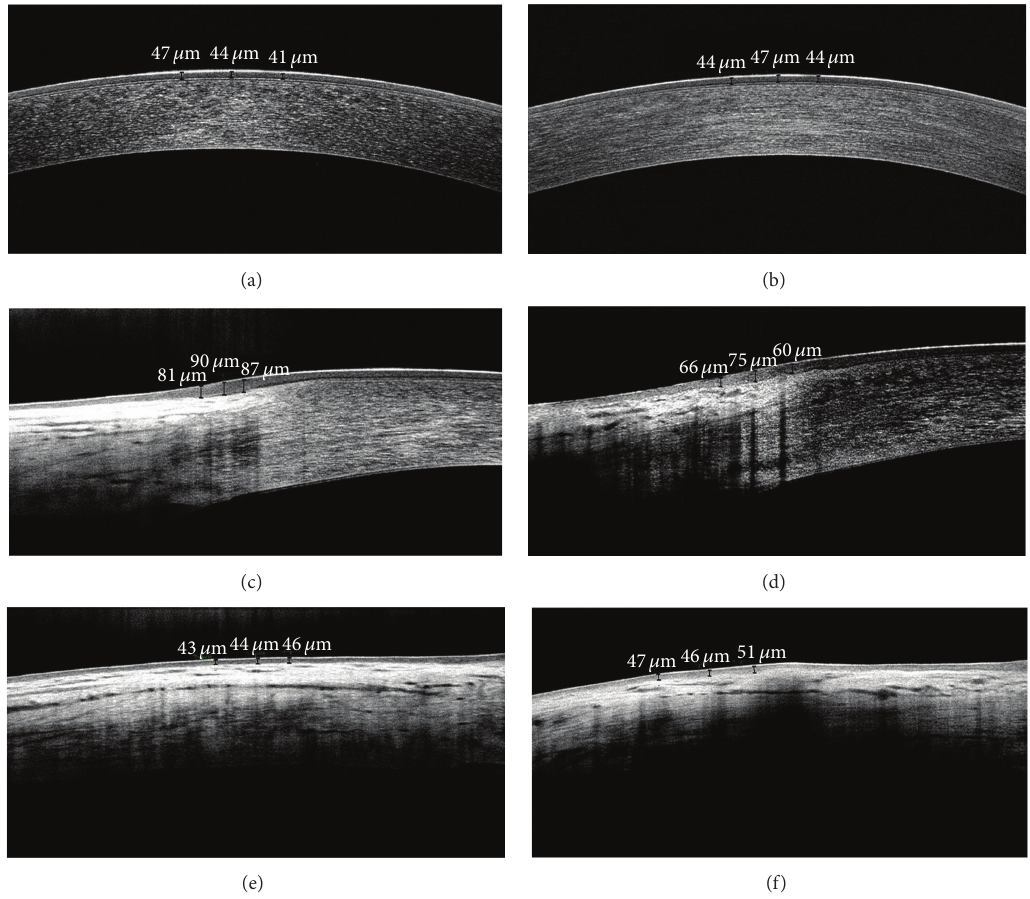
Figure 1: SD-OCT images of ocular surface epithelial thickness measurement in a healthy control subject (a, c, e) and a dry eye patient (b, d, f). Corneal epithelium thickness measurement with software cursors (a, b), limbus and conjunctiva epithelium thickness analysis (c, d), and conjunctiva epithelium thickness measurement (e,